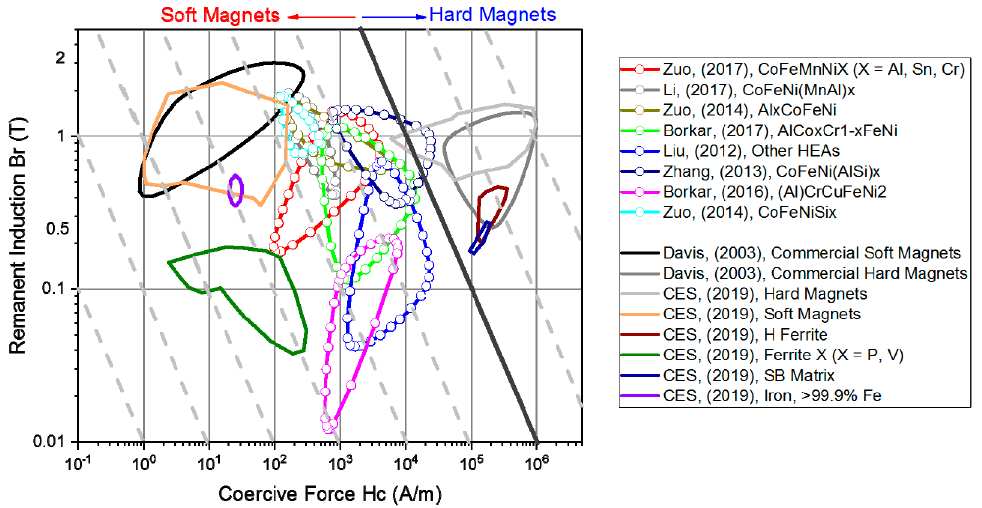
Figure 4. Material property spaces for HEAs and CCAs, comparing remanent induction vs. coercive force for conventional metal alloys (lines) and HEAs (symbols). (Data taken from [27,29,43,75–77,81,82]). The data is from the CES EduPack 2009, Granta Design, Limited, Cambridge, UK, 2009.